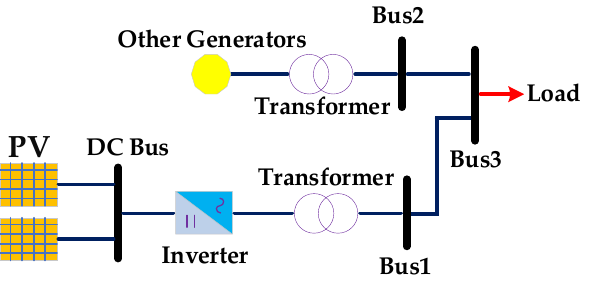
Figure 1. Schematic diagram of PV system reactive power regulation.